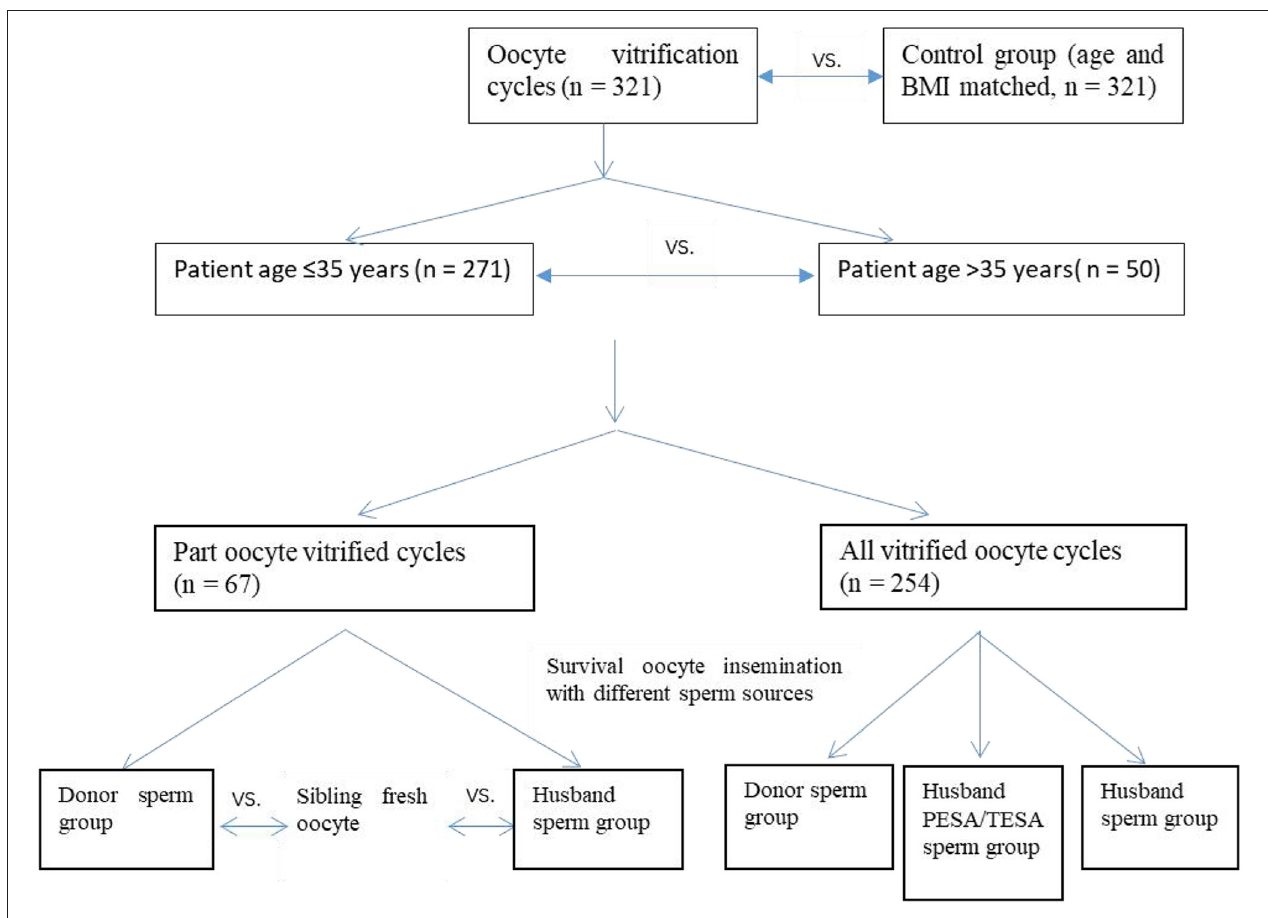
FIGURE 1 | Description of experimental groups and comparisons.